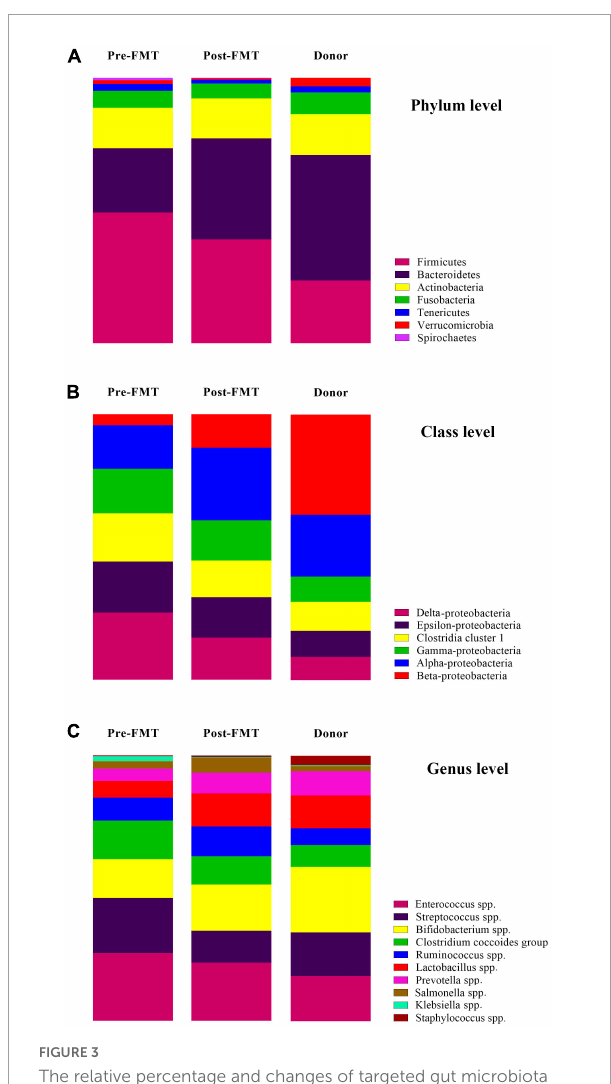
FIGURE3 The relative percentage and changes of targeted gut microbiota communities in fecal samples of healthy donors, and patients before (pre-FMT) and after (post-FMT) fecal microbiota transplantation (FMT). (A) Gut microbiota composition and alterations at the phylum level. (B) Gut microbiota composition and alterations at the class level. (C) Gut microbiota composition and alterations at the genus level. Data are presented as mean ± SD. Each color corresponds to a type of microbiota included in this